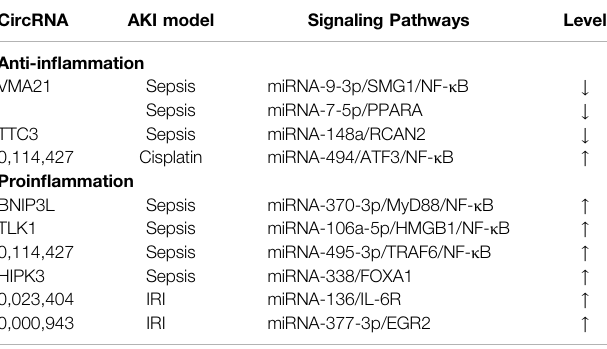
TABLE 3 | Role of circRNAs in in fl ammatory response of AKI.